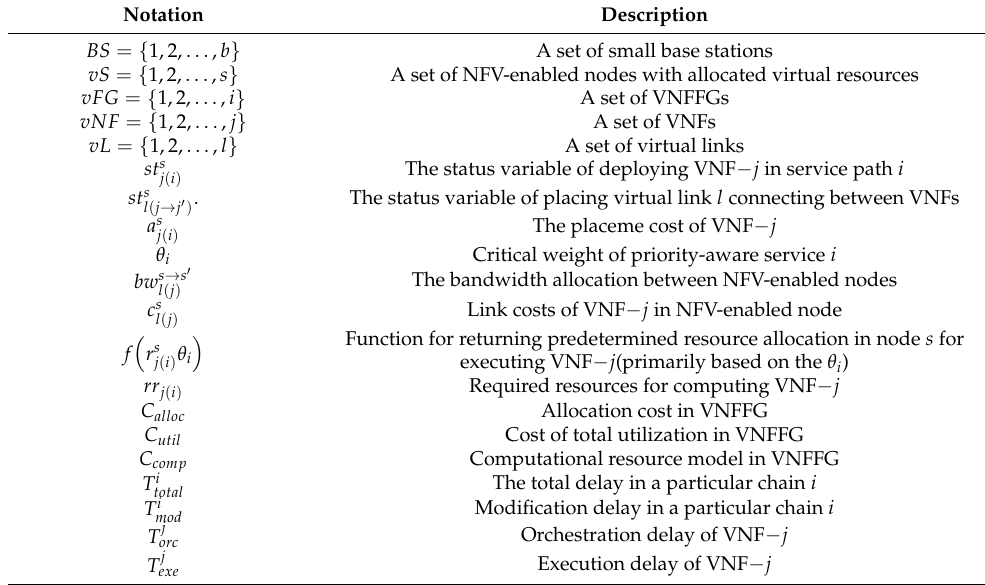
Table 2. Key notations used in the system models and proposed mechanism formulation.